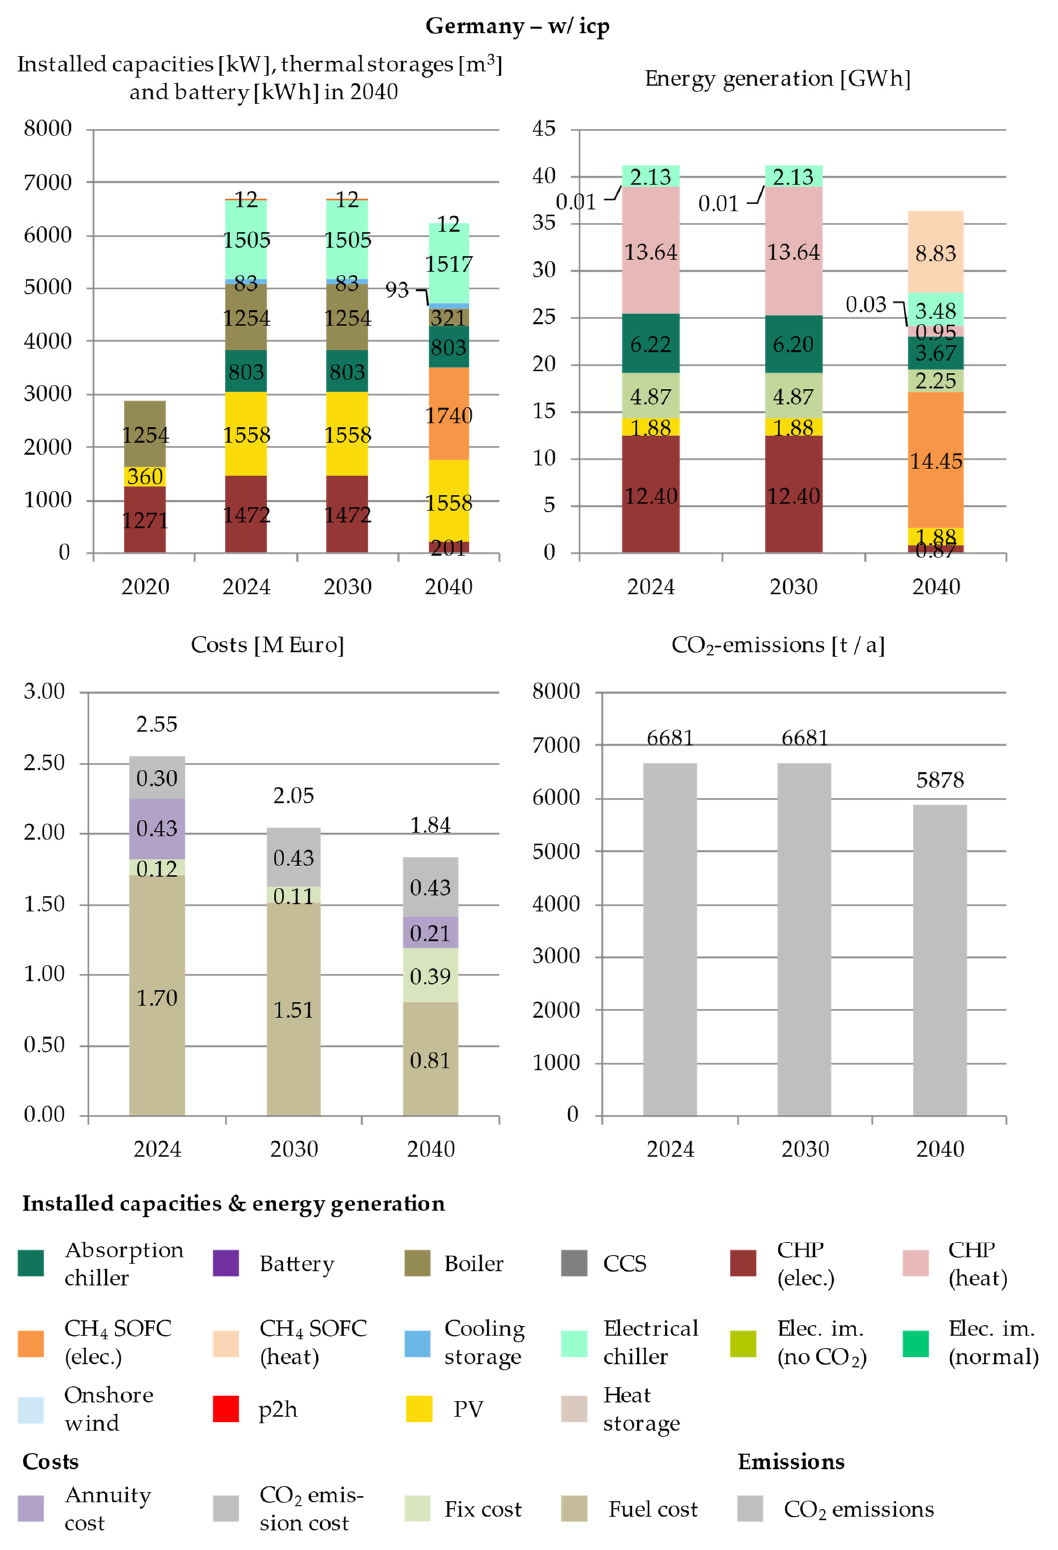
Figure A2. Detailed results for the German “w/ICP” scenario.